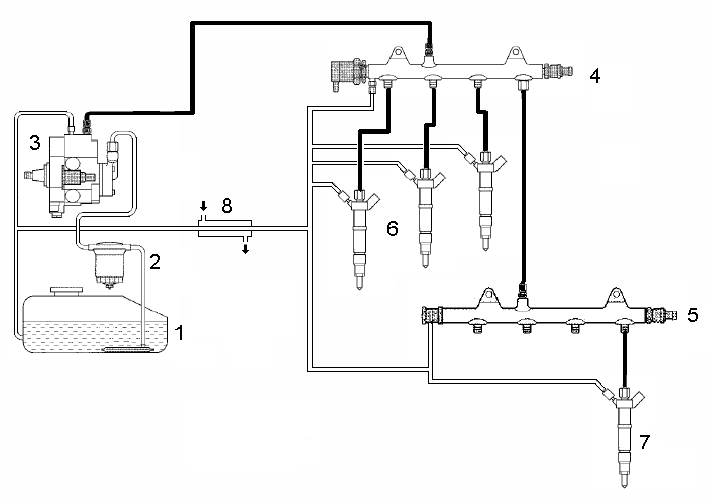
Figure 2. Experimental setup of Diesel injecting system. (1) Fuel tank, (2) lift pump and filter, (3) Bosch CP3, (4) rail with pressure control valve, (5) tested modern rail with pressure relief valve, (6) injectors for overspilling fuel in case of valve failure, (7) tested injector, (8) fuel cooler.